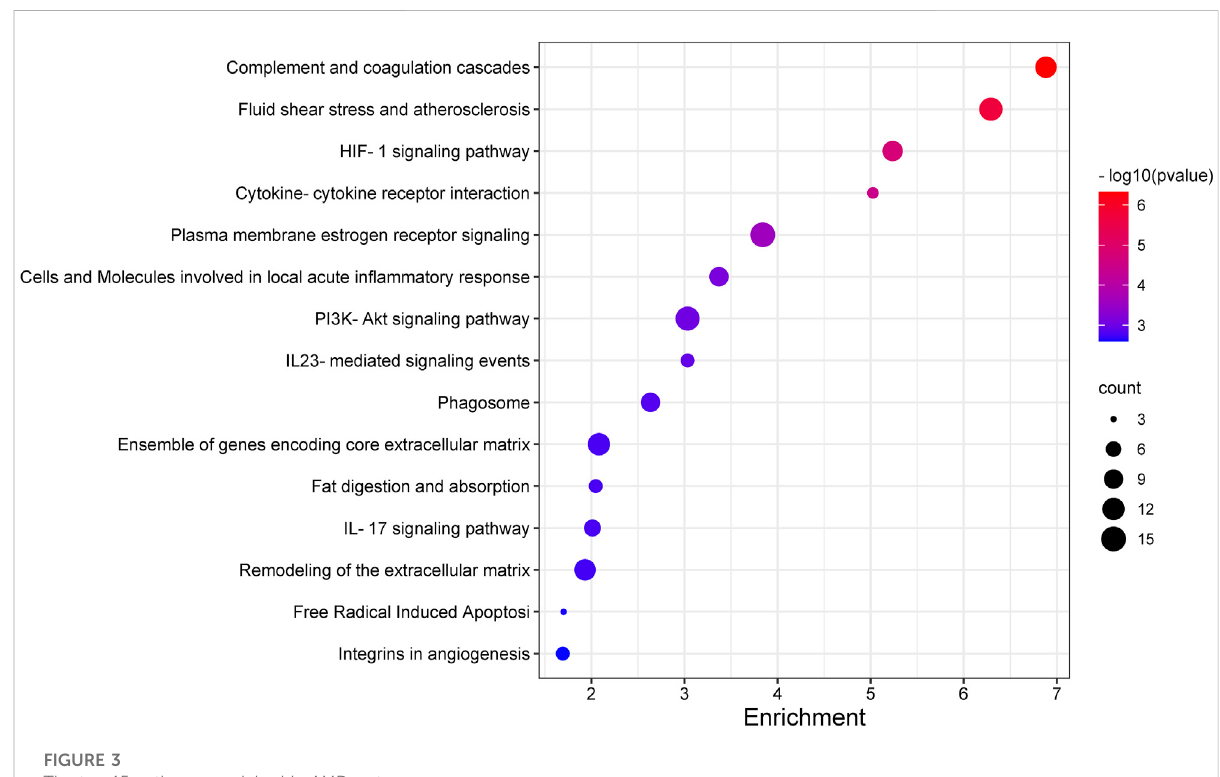
FIGURE 3 The top 15 pathways enriched in